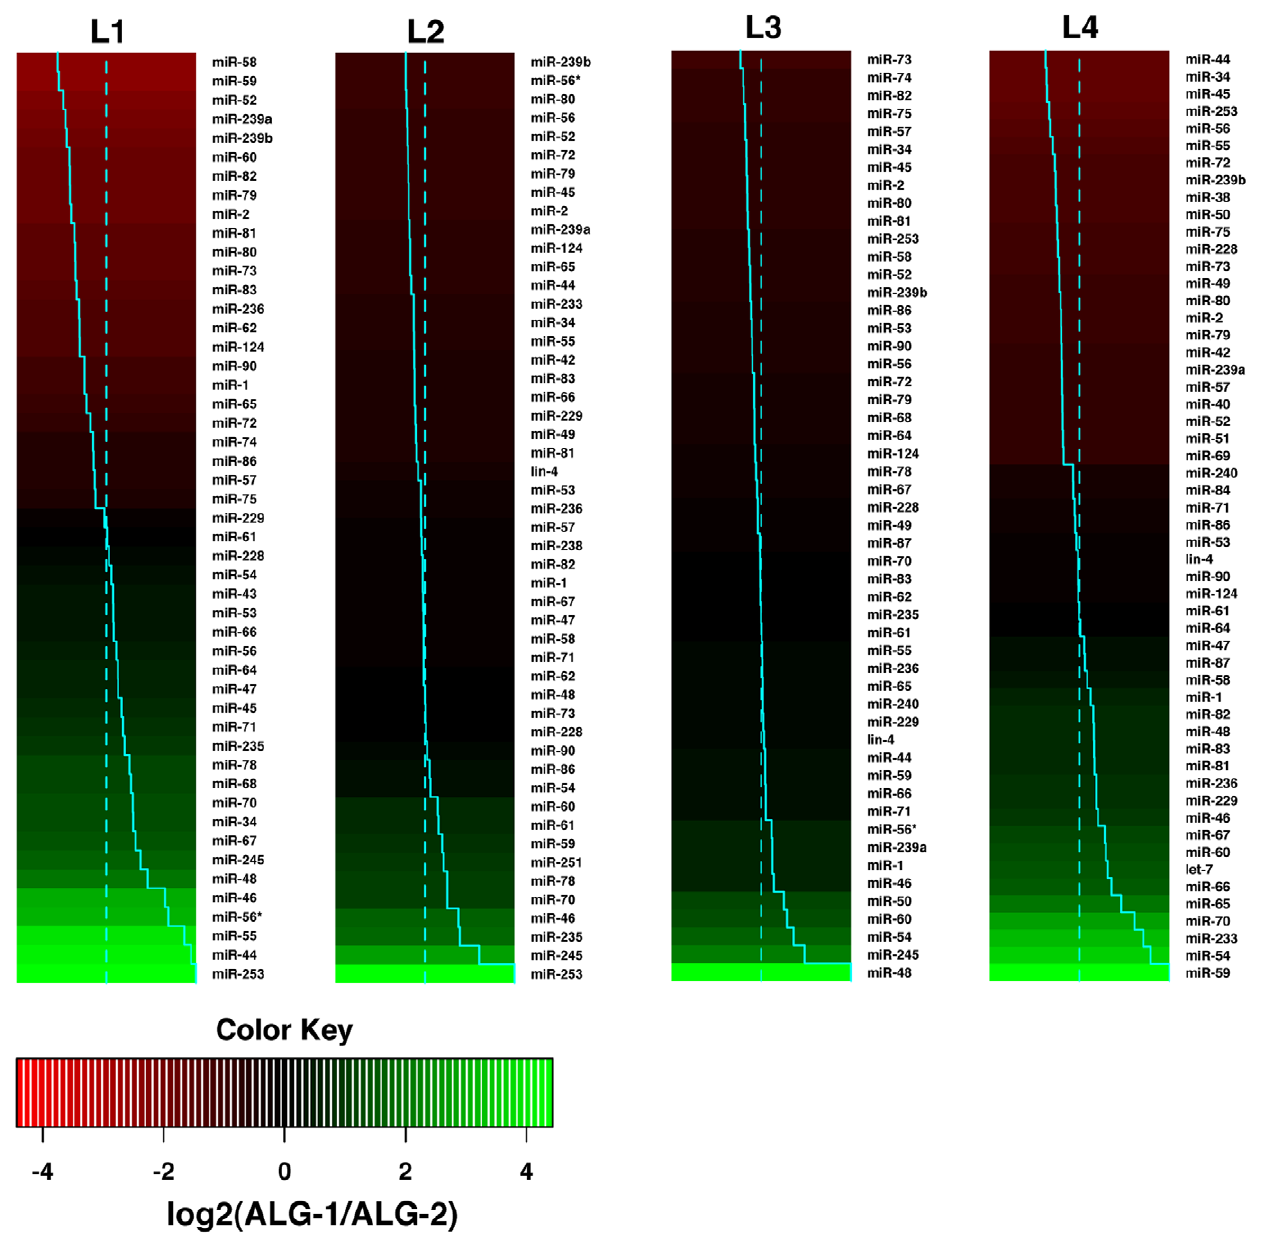
Figure 5. Relative microRNA association with ALG-1 and ALG-2. Heatmaps representing the ratios of ALG-1 to ALG-2 associated miRNAs at the larval stages indicated as estimated from miRNA microarrays (towards red: stronger association to ALG-2, towards green: stronger association to ALG-1). miRNA expression data were filtered for robustly expressed miRNAs. Ratios were log2 transformed, centered and normalized for each column. The distance of the solid blue line from the center of each color-cell is proportional to the ratio. Mean ratio indicated as dotted blue line.